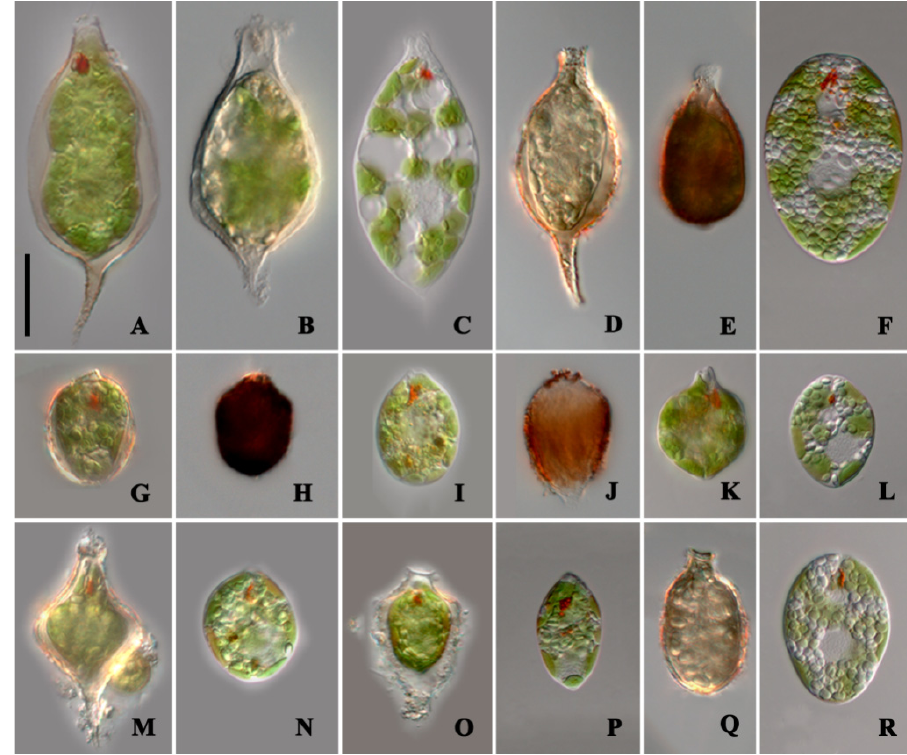
Figure 4. Morphology of Strombomonas strains in this study: ( A – I ) each species includes: morphology of lorica in the field (left), morphology of lorica in culture (middle), protoplast morphology (right); ( A – C ) S. maxima strain SHNUS6A3; ( D – F ) S. fluviatilis strain SHNUQ6B2; ( G – I ) S. borystheniensis strain SHNUQ6C2; ( J , K ) Morphology of S. verrucosa strain SHNUS28C1; ( L ) protoplast morphology of S. ovalis strain SHNUS49C6; ( M – R ) each species including: morphology of lorica in the field (left), protoplast morphology (right); ( M , N ) S. gibberosa strain SHNUQ6A1; ( O , P ) S. triquetra strain SHNUQ6A4; and ( Q , R ) S. cf. borystheniensis strain SHNUQ6C3. Species are all in the same scale, scale bar 20 µ m. Table 1. Morphological characters of Trachelomonas and Strombomonas strains in this